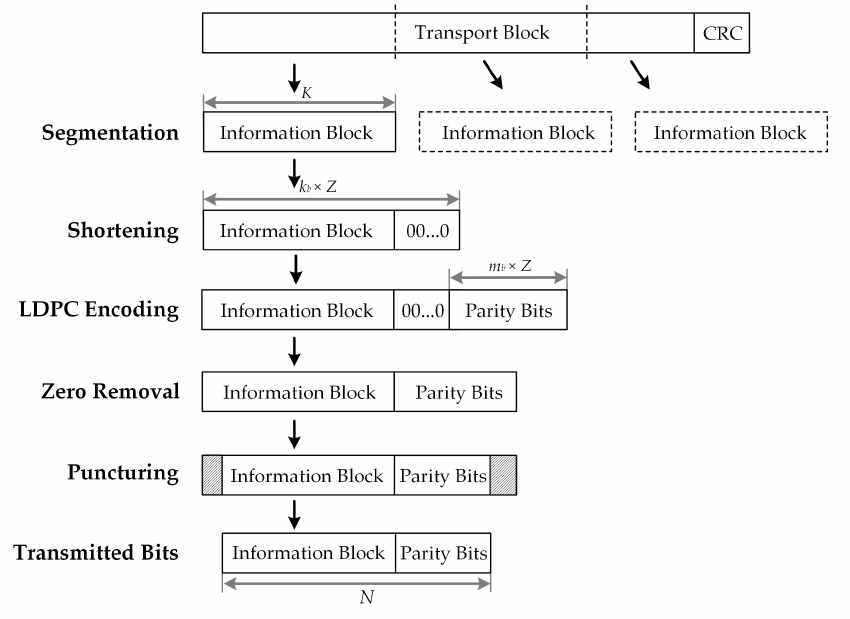
Figure 2. Shortening by zero-padding and puncturing of standard 5G QC-LDPC